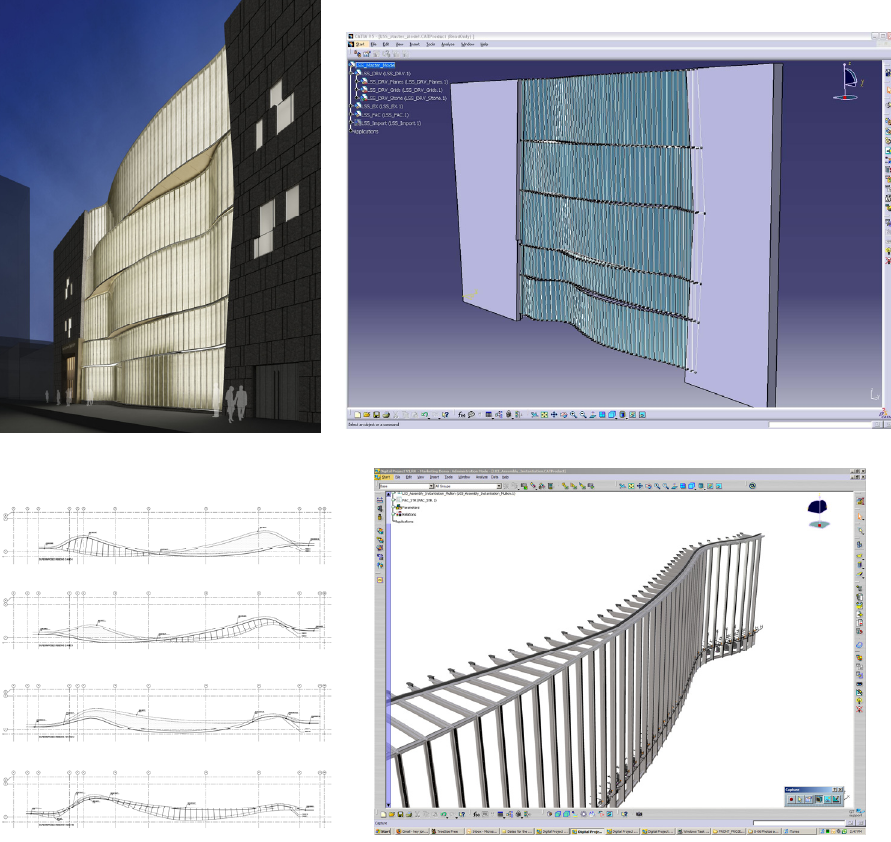
Figure 5a, b, c, d: LSS Rendering, CATIA Wireframe, Ribbon Geometry, CATIA Model